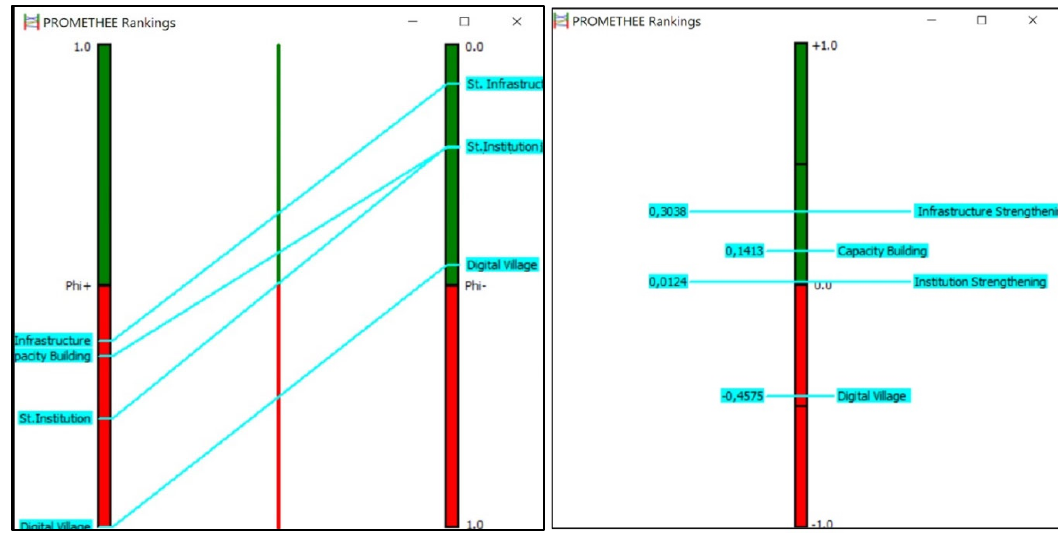
Fig. 3. Partial Ranking and Complete Ranking of Tourism Village Development